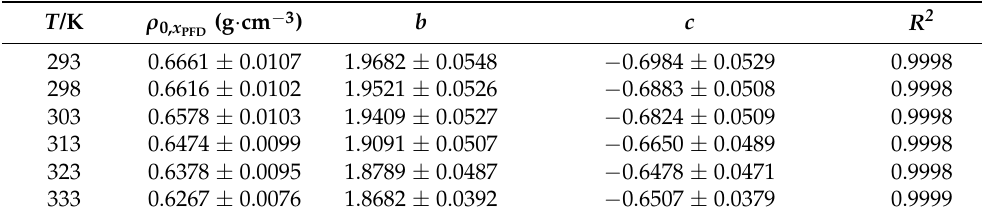
Table 3. Result of the regression analysis of density ( ρ /g · cm − 3 ) versus mole fraction of PFD ( x PFD ) data according to equation: ρ /(g · cm − 3 ) = ρ 0, x /(g · cm − 3 ) + b ( x PFD ) + c ( x PFD2 ) for the investigated PFD mixtures over the temperature range 293 K to 333 K. a T /K